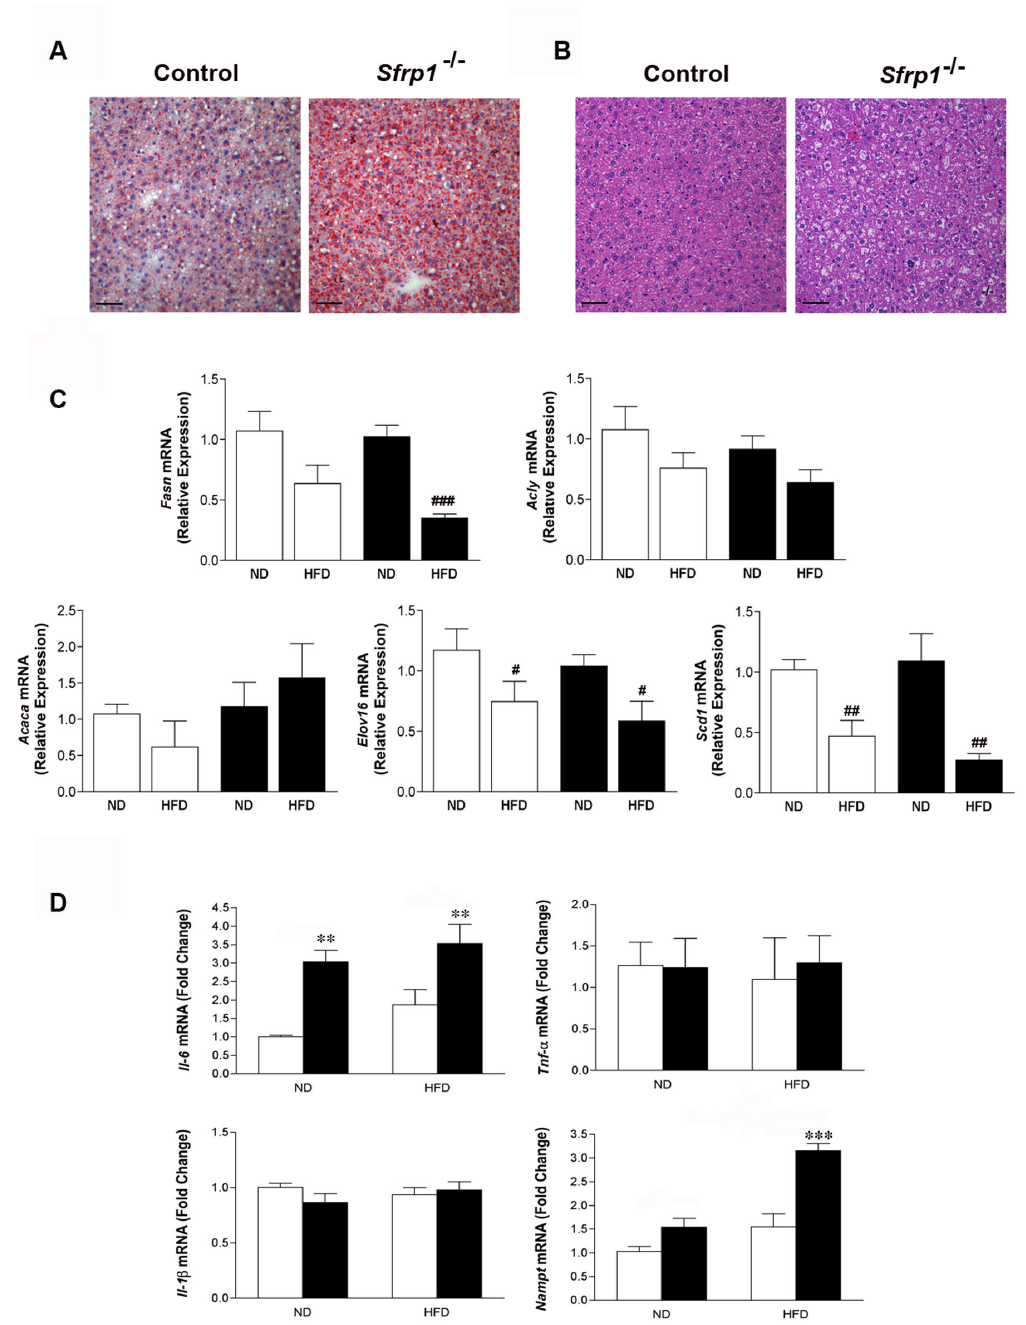
Figure 3. Hepatic steatosis and inflammation exhibited by Sfrp1 -/- mice. (A) Steatosis is distinguished by Oil Red O staining of lipids. Images were captured at 400X and represent control mice and Sfrp1 -/- mice on a HFD (scale bar 50 μm). (B) H&E staining of livers and captured as described above. (C) Total RNA from the livers in each group (n=6) was utilized for real-time PCR analysis of Fasn , Acly, and Acaca, Elov 16, and Scd 1 gene expression. The results shown represent experiments performed in duplicate and normalized to the amplification of β-actin mRNA. Bars represent mean ± SEM of the relative expression with respect to ND fed mice. (D) Real-time PCR analysis of liver Il-6 , Tnf -α, Il-1β, and Nampt gene expression was carried out as described above. Bars represent mean ± SEM of the difference in fold change compared with control ND fed mice. (*p<0.05, **p<0.01, ***p<0.001 significantly different from control mice fed a ND using Bonferroni’s t test after a two-way ANOVA; # p<0.05, ## p<0.01, ### p<0.001 significantly different from respective ND fed mice using student’s t test.). doi: 10.1371/journal.pone.0078320.g003 PLOS ONE |